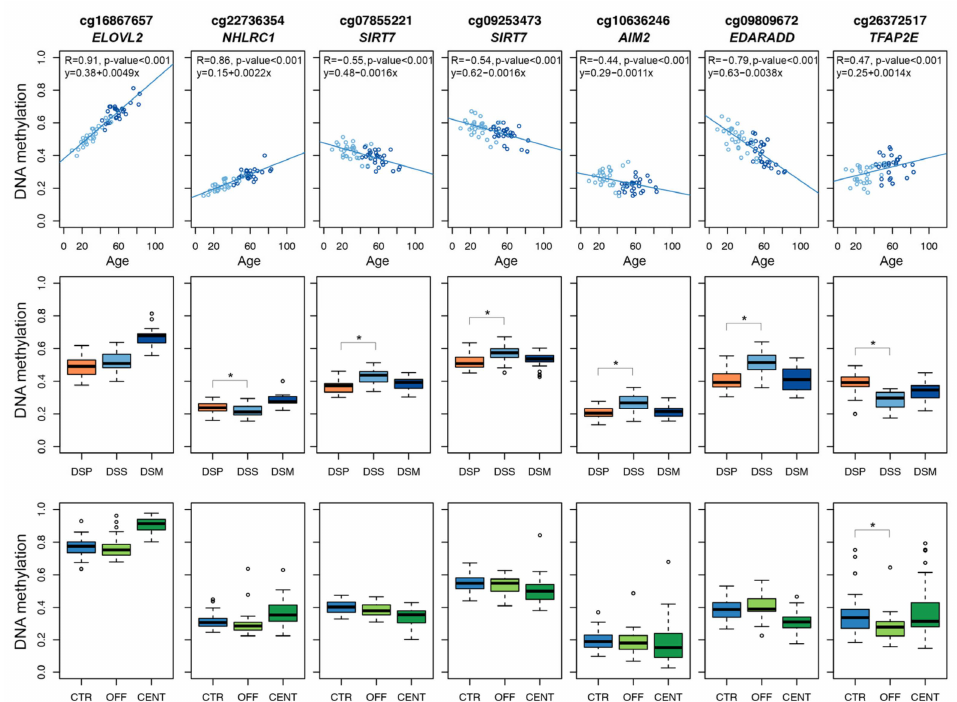
Figure 1. DNAm profiles of the 7 Infinium CpG probes selected for developing the targeted epigenetic assay. Each dot represents a subject. Upper panels: scatter-plots of DNAm values vs. chronological age in DSS and DSM; Spearman correlation coefficient and the equation of the regression line are reported for each CpG probe. Middle panels: boxplots of DNAm in DSP, DSS and DSM. Lower panels: boxplots of DNAm values in CENT, OFF and CTR. For the comparisons DSP vs. DSS and OFF vs. CTR, asterisks indicate statistically significant differences ( p -value <